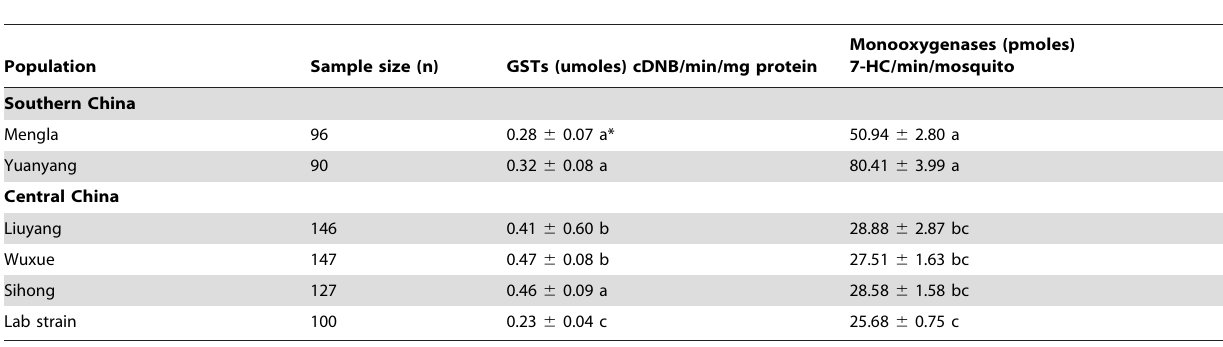
Table 3. Glutathione s-transferases (GSTs) and monooxygenases activity in Anopheles sinensis female adults in five populations in China when compared with lab susceptible